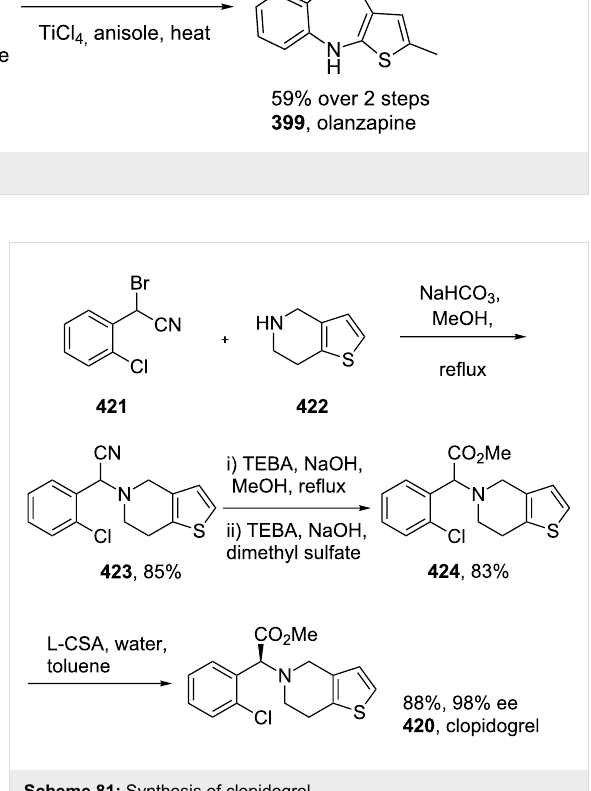
Scheme 81: Synthesis of